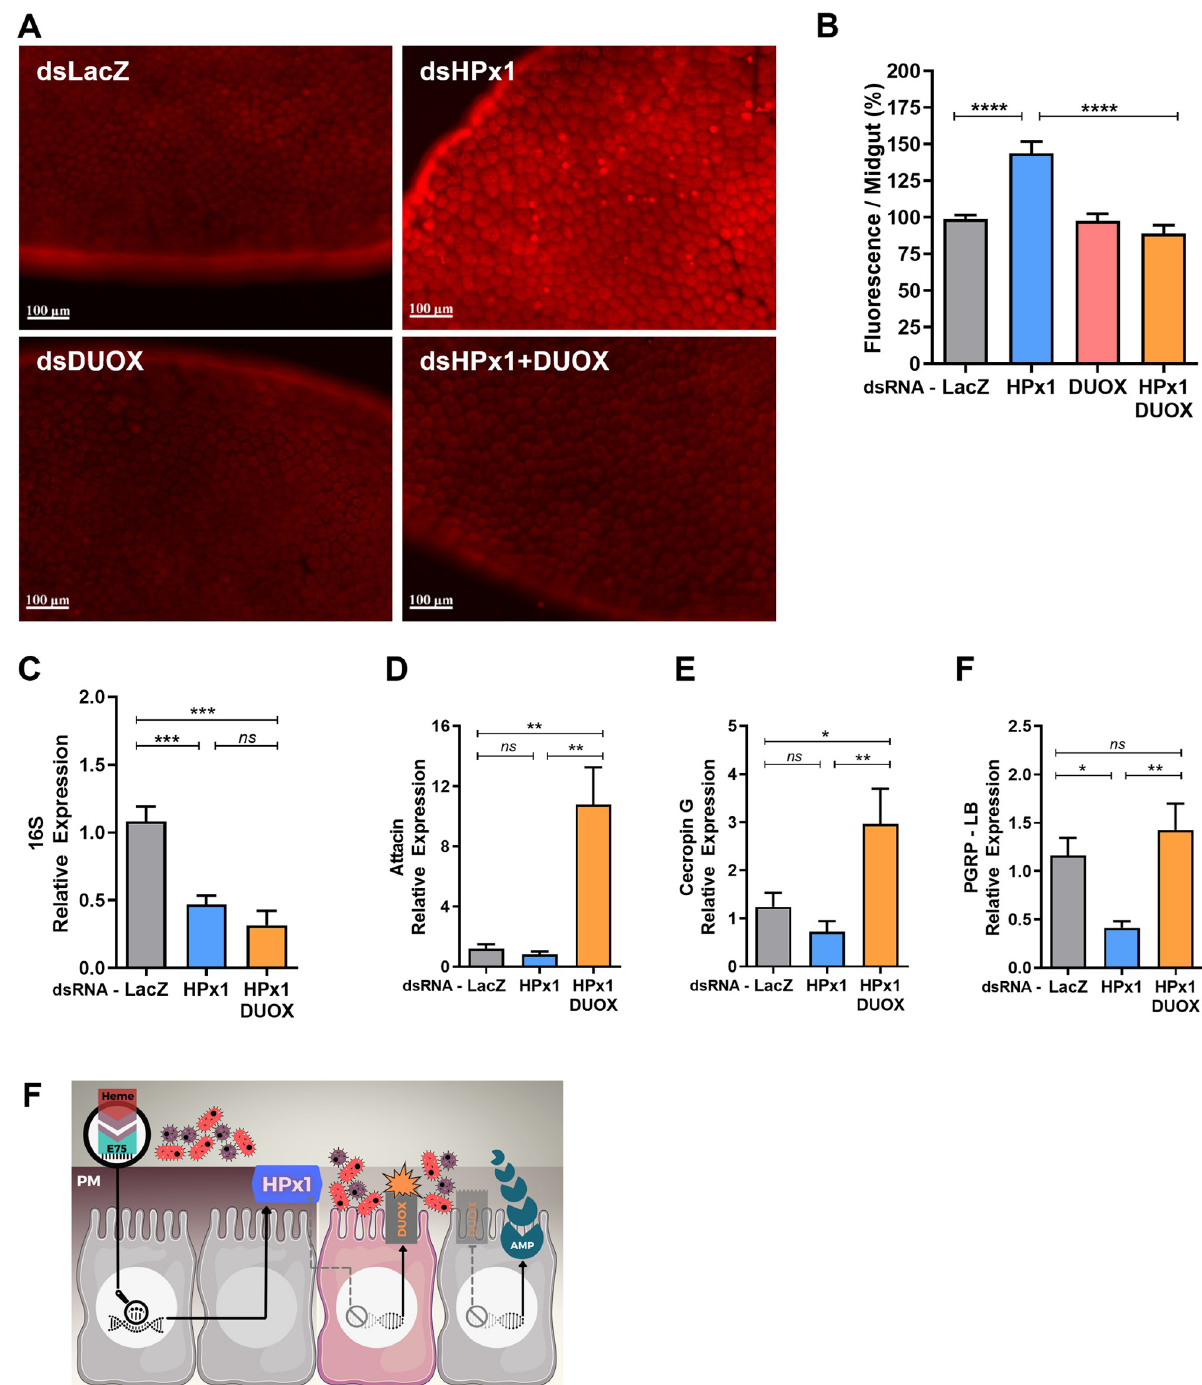
Fig 4. DUOX activation upon HPx1 silencing and hierarchical mode of activation of innate immunity in the mosquito midgut. A) Representative images of ROS levels measured by DHE oxidation in individual midguts at 18 h ABM. B) Quantitative analysis of the fluorescence intensity of oxidized DHE (dsLacZ, n = 38; dsHPx1, n = 43; dsDUOX, n = 21; dsHPx1+DUOX, n = 31). C) The intestinal microbiota load analyzed through eubacterial ribosomal 16S gene expression by qPCR at 24 h ABM (dsLacZ n = 6; dsHPx1 n = 6; dsHPx1+DUOX n = 4). D-F) Immune-related gene expression upon HPx1 silencing at 24 h ABM by qPCR (at least n = 5 for each condition). F) Schematic panel of intestinal immune activation showing that the PM integrity mediated by HPx1 activity isolates the gut microbiota, and once this integrity is lost, DUOX and antimicrobial peptides (AMPs) are activated. �� p < 0.005, ��� p < 0.001, ���� p < 0.0001, ns = not significant. Data are the mean +/- SEM. One-way ANOVA with Tukey’s post-test for A’, B, and C.